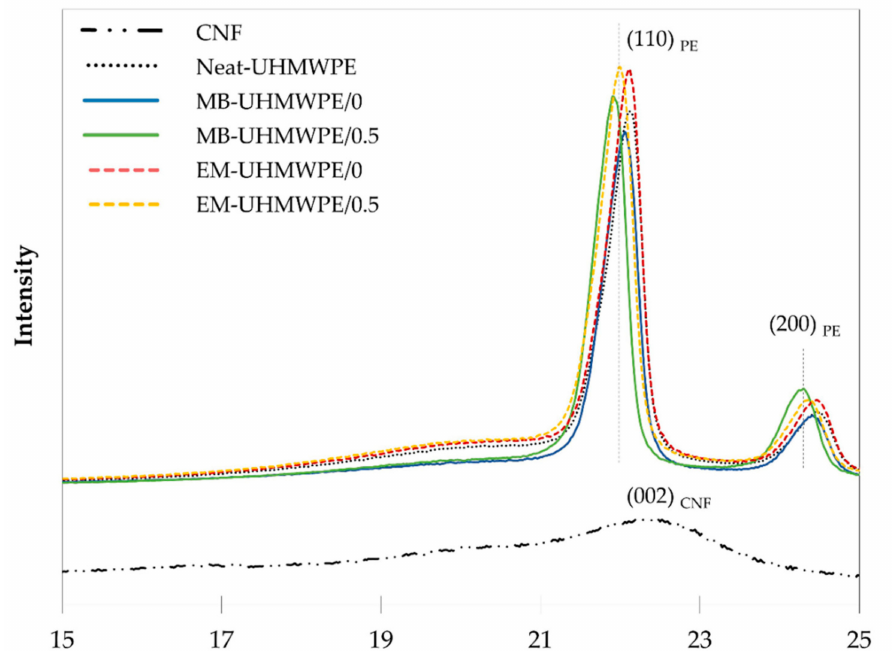
Figure 9. X-ray diffractogram of UHMWPE/CNF